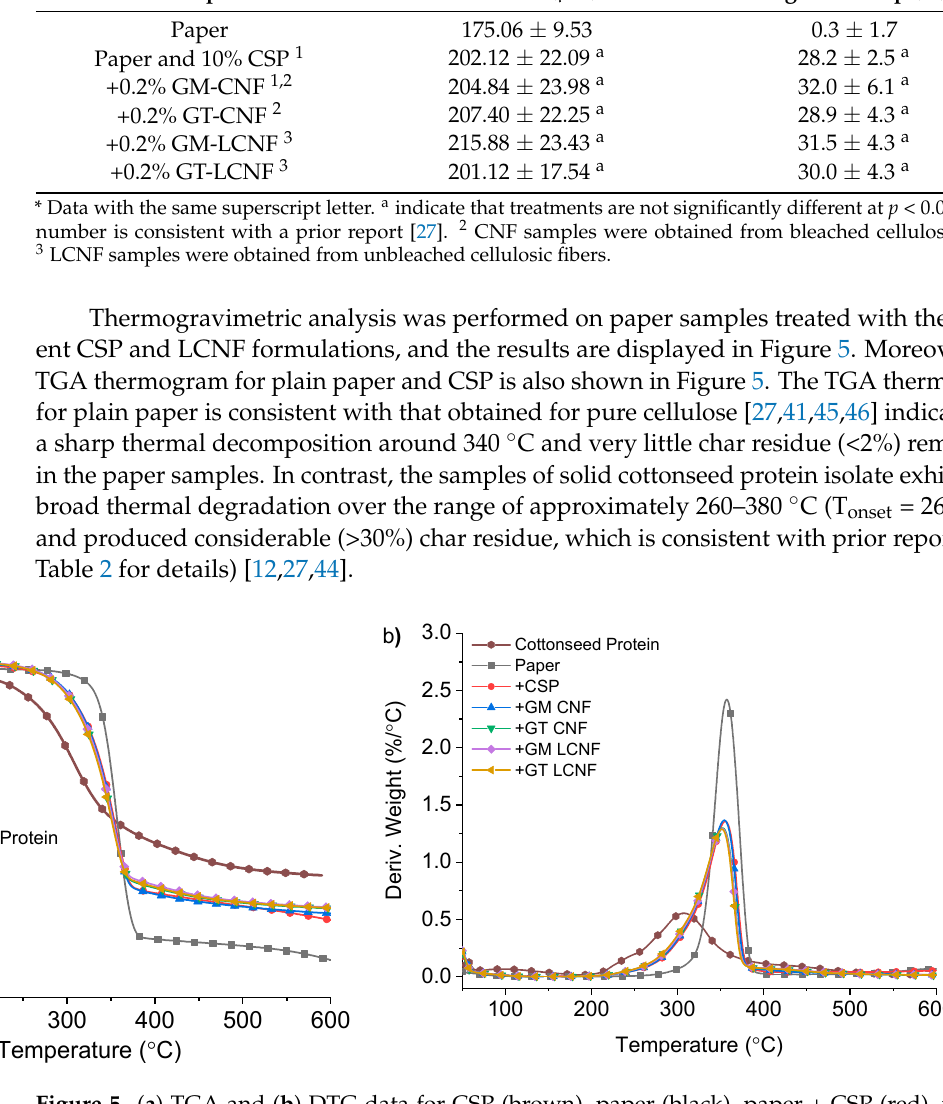
Figure 5. ( a ) TGA and ( b ) DTG data for CSP (brown), paper (black), paper + CSP (red), paper + CSP+GM-CNF (blue), paper + CSP + GT-CNF (green), paper + CSP + GM-LCNF (violet) and paper + CSP + GT-LCNF (gold); DTG—differential thermogravimetry; TGA—thermogravimetric analysis.